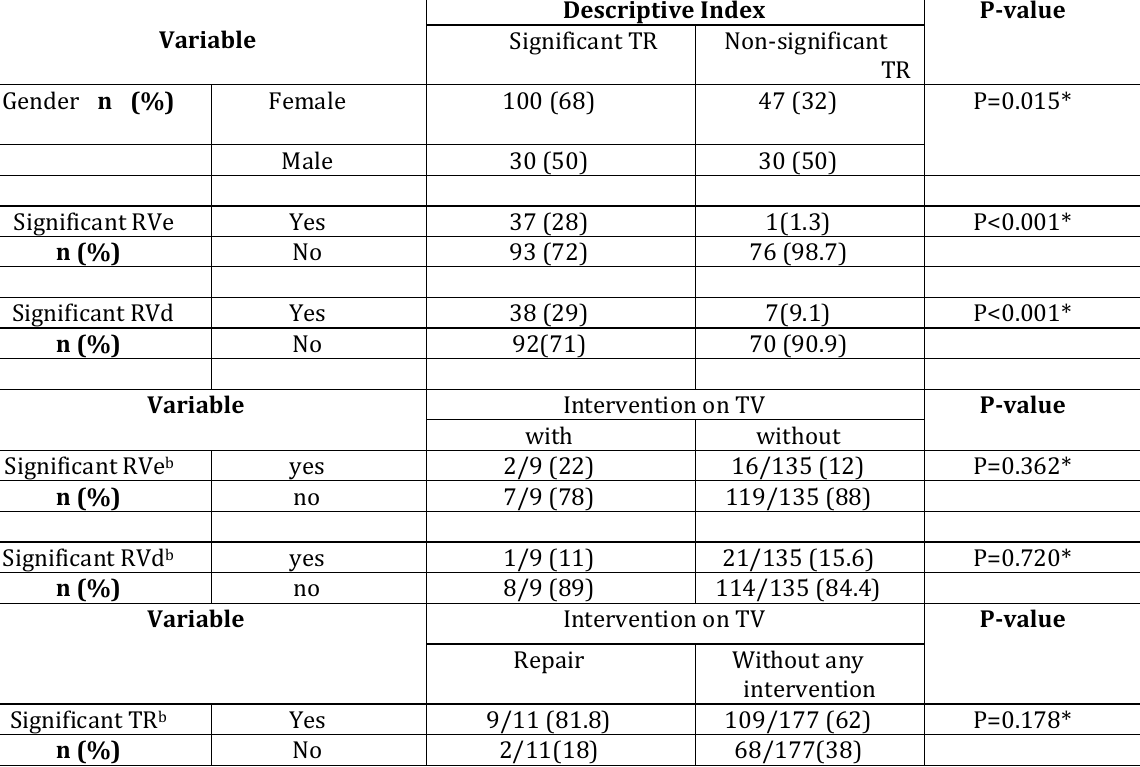
Table 2. Comparison of changes in echocardiographic parameters after mitral valve replacement